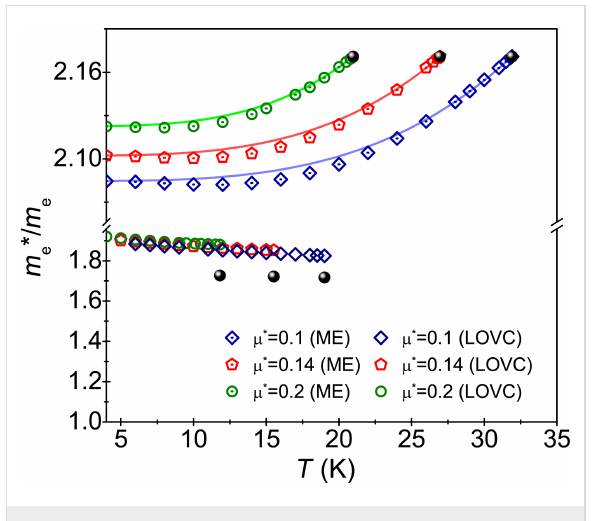
Figure 4 using black spheres. We obtained a good agreement between numerical and analytical results.